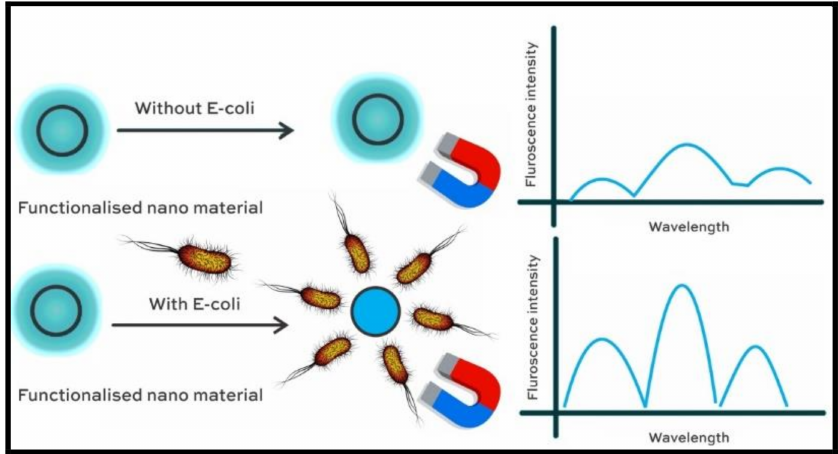
Figure 6. Schematic description of magnetic nanoparticle-based aptamer